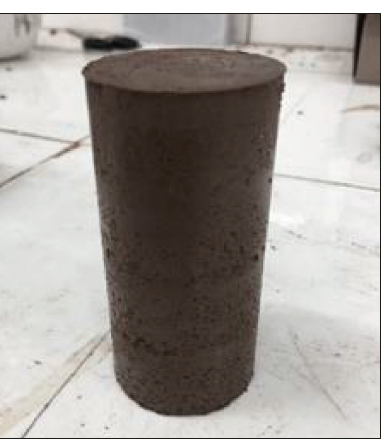
Figure 5: Cement soil sample.